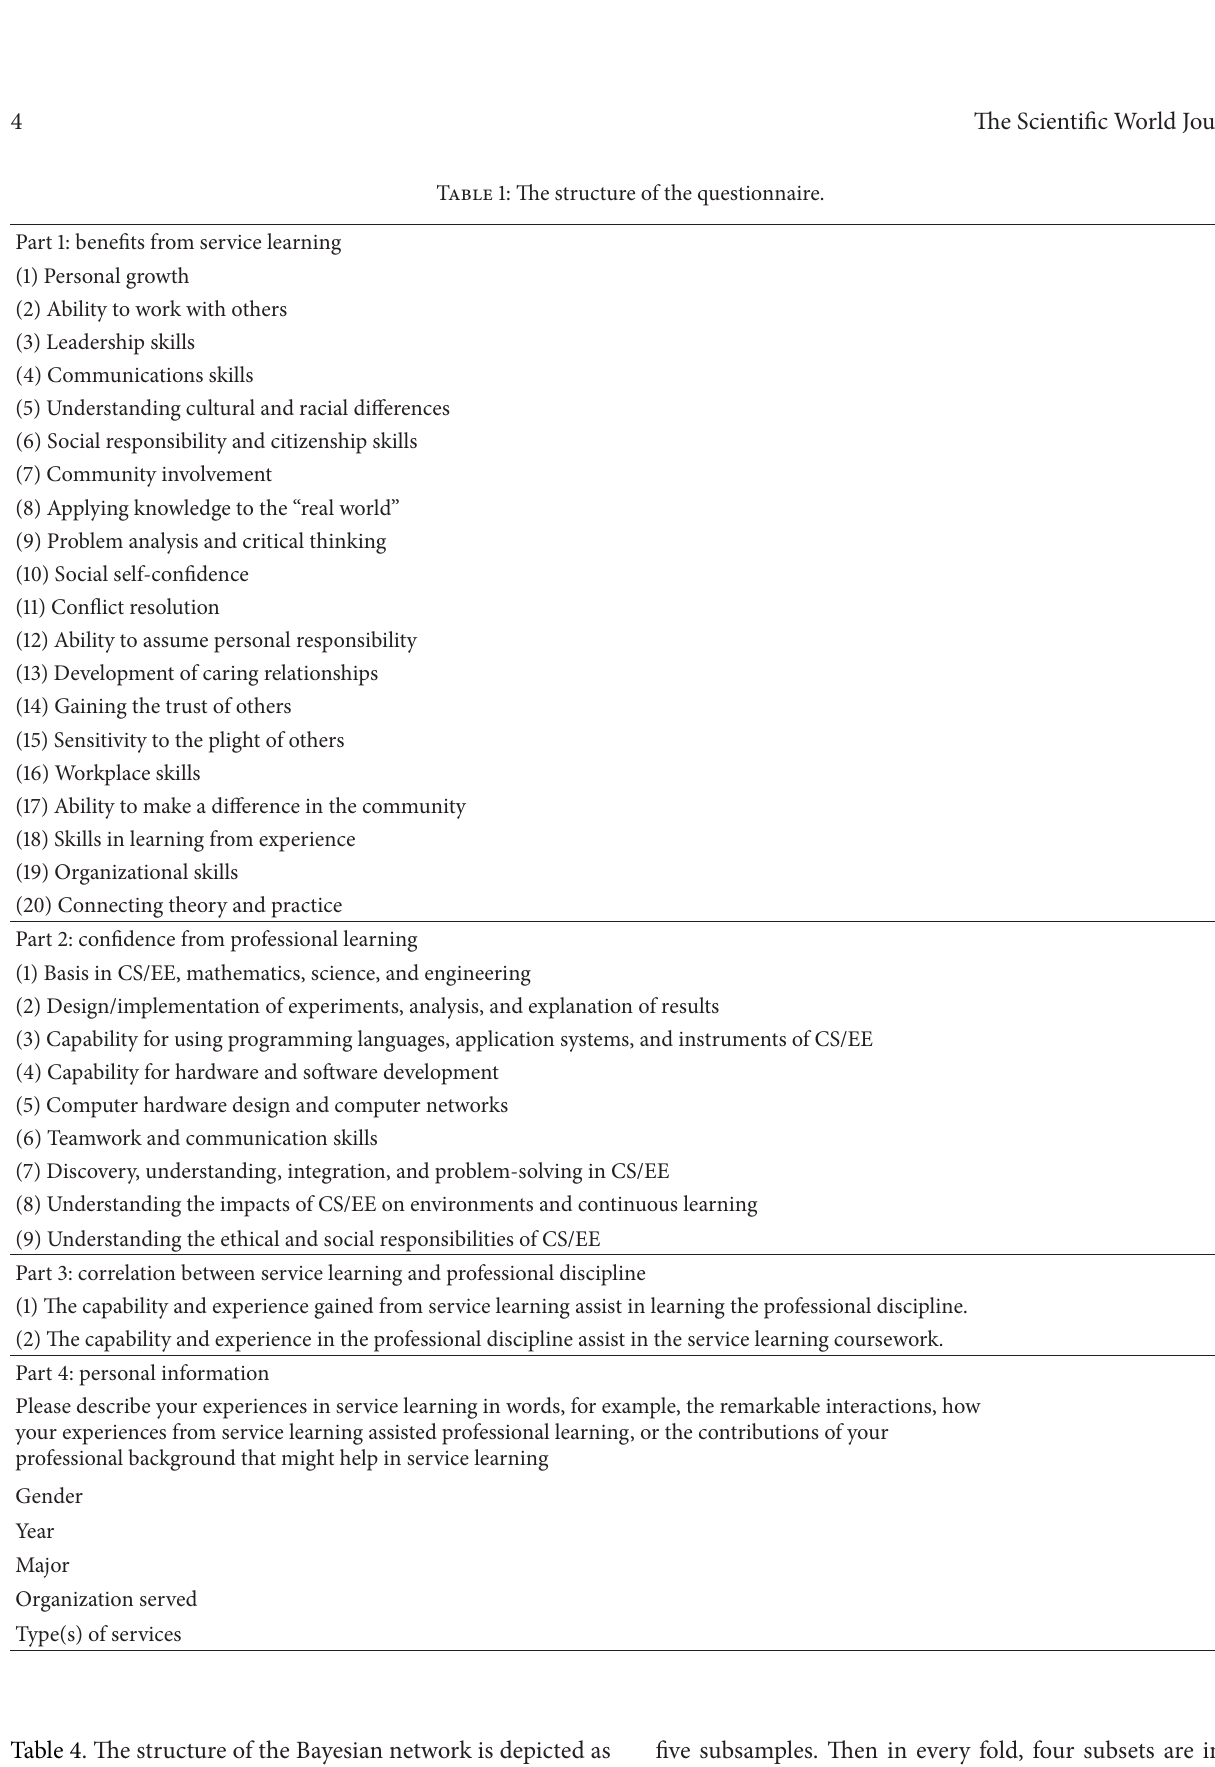
Table 4. The structure of the Bayesian network is depicted as Figure